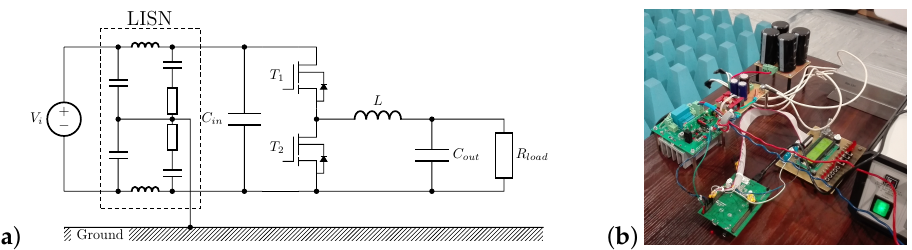
Figure 1. The buck converter: ( a ) circuit schematic and ( b ) experimental setup.